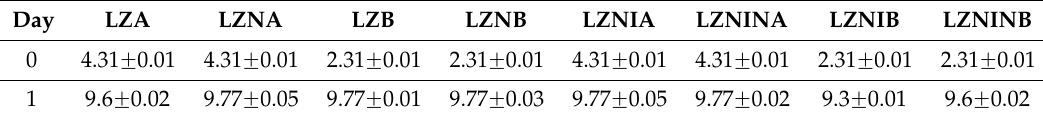
Table 2. Average and SD of counts of L. lactis subsp. lactis DSM 20729 in the co-cultures with L. plantarum LZ and LZNI at time 0 and day 1.